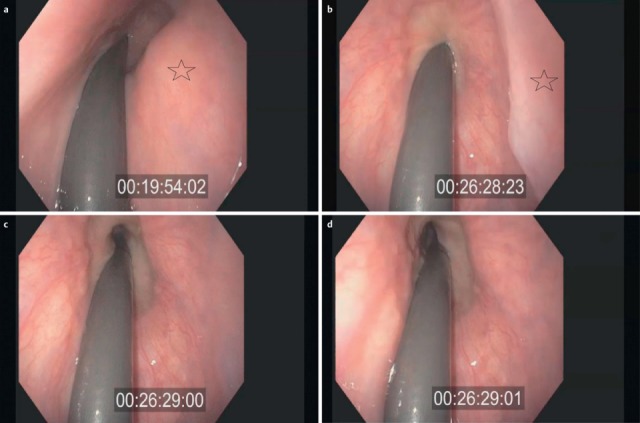
Position 4 – upper esophageal sphincter during eructation in a retrograde view (on the right side, a vertebra is visible (*)); a – upper esophageal sphincter at rest without increased pressure; b – the lower sphincter was open (pressure balance); the space of the upper esophageal sphincter is wider because of increased pressure, the circular muscles are tense (yellow color); c – the circular fibers open first (NB time code); d – the cricopharyngeal muscle is open, its contours are visible (NB time code).